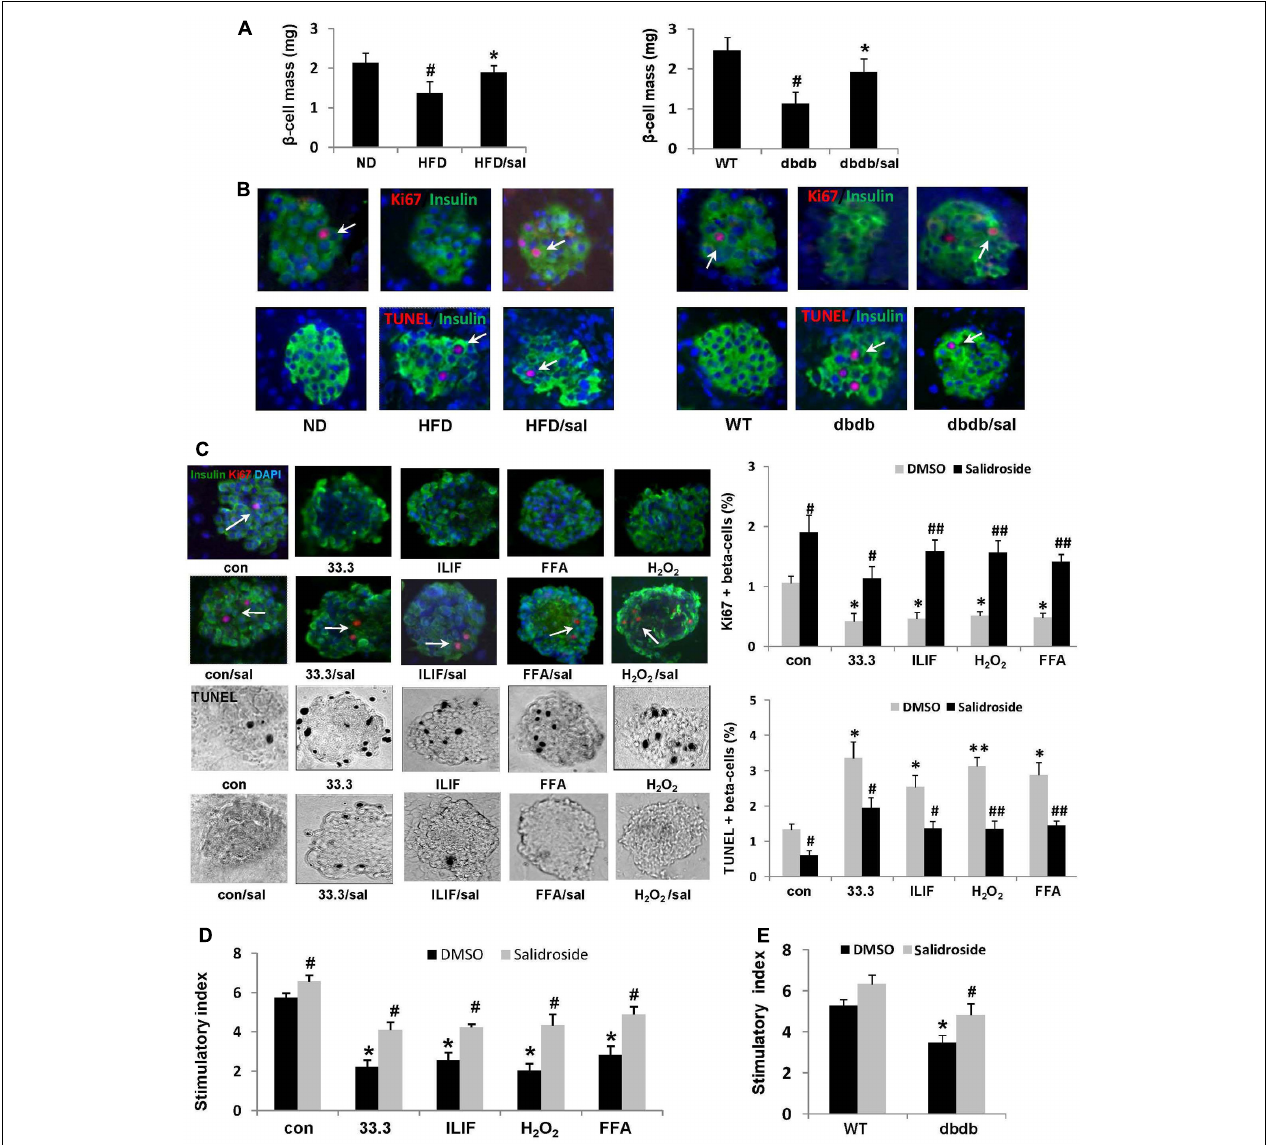
FIGURE 3 | Salidroside improved β -cell survival under diabetic condition. (A) Five consecutive sections from each pancreas (6 mice per group) were used for β -cell mass measurements. Data are shown as mean ± SE, n = 6 ( # p < 0.05 db/db to WT or HFD to ND, ∗ p < 0.05 dbdb to dbdb/sal or HFD to HFD/sal). (B) Replication of β -cell in mice was examined in pancreatic sections by staining for Ki67 in red (indicated by white arrows), insulin in green, and DAPI in blue. β -cell apoptosis was detected by TUNEL staining in red (indicated by white arrows), insulin in green, and DAPI in blue. Representative pictures were shown. (C) Isolated mouse islets were exposed to diabetic stimuli [33.3 mM glucose or the mixture of 2 ng/ml IL-1 β +1,000 U/ml IFN- γ (ILIF), or 0.5 mM palmitic acid], and H 2 O 2 as a positive inducer of ROS (200 uM) with or without salidroside (50 µ M) or DMSO as control for 3 days. Proliferation of β -cell was measured by the Ki67(red)/insulin(green)/DAPI(blue) co-staining (Ki67 positive staining was indicated by white arrows), and apoptosis by the TUNEL assay (black and white pictures, TUNEL positive presented as black dots). Results are expressed as means ± SE of the percentage of Ki67-positive or TUNEL-positive β -cells ( ∗ p < 0.05, ∗∗ p < 0.01 diabetic stimuli to control, # p < 0.05, ## p < 0.01 salidroside to DMSO). (D) GSIS assay was performed in cultured mouse islets with different treatments. Stimulatory index denotes the amount of stimulated divided by the amount of basal insulin secretion. Data are shown as mean ± SE from three independent experiments ( ∗ p < 0.05 diabetic stimuli to control, # p < 0.05 salidroside to DMSO). (E) GSIS assay was performed in cultured mouse islets isolated from WT mice and db/db mice treated by salidroside or DMSO ( ∗ p < 0.05 db/db to WT mice, # p < 0.05 salidroside to